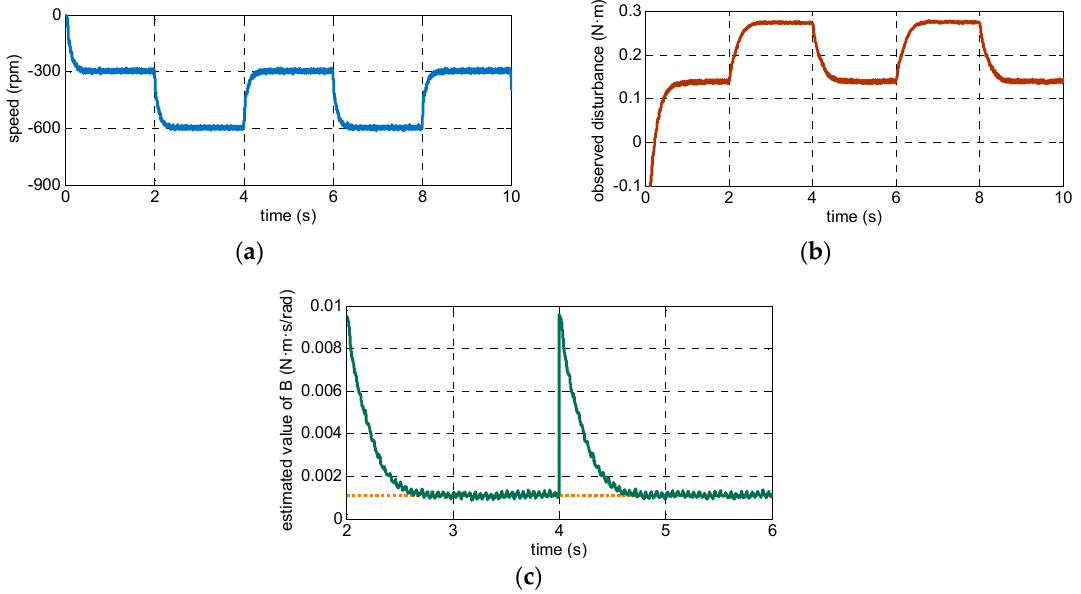
Figure 13. Experimental results under alternate speeds of − 300 and − 600 rpm for B 0 = 5 B : ( a ) Measured speed; ( b ) observed disturbance value for parameter mismatch error Δ B ; ( c ) estimated value of parameter B .